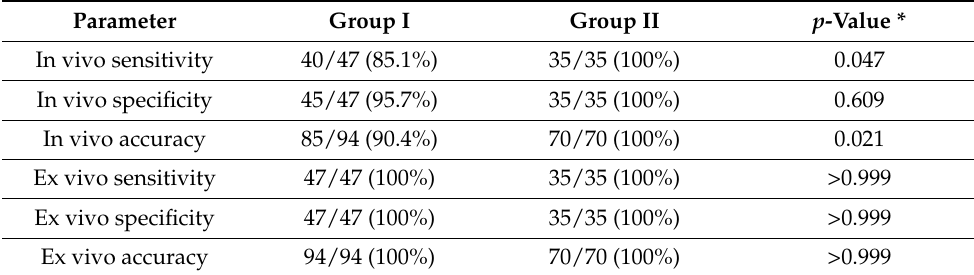
Table 3. Comparison of in vivo and ex vivo parameters of radio guidance between